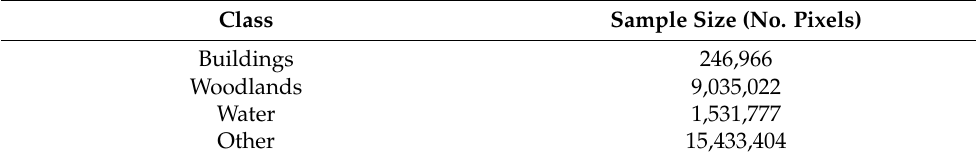
Table 8. Accuracy assessment data used for semantic segmentation of LandCover.ai